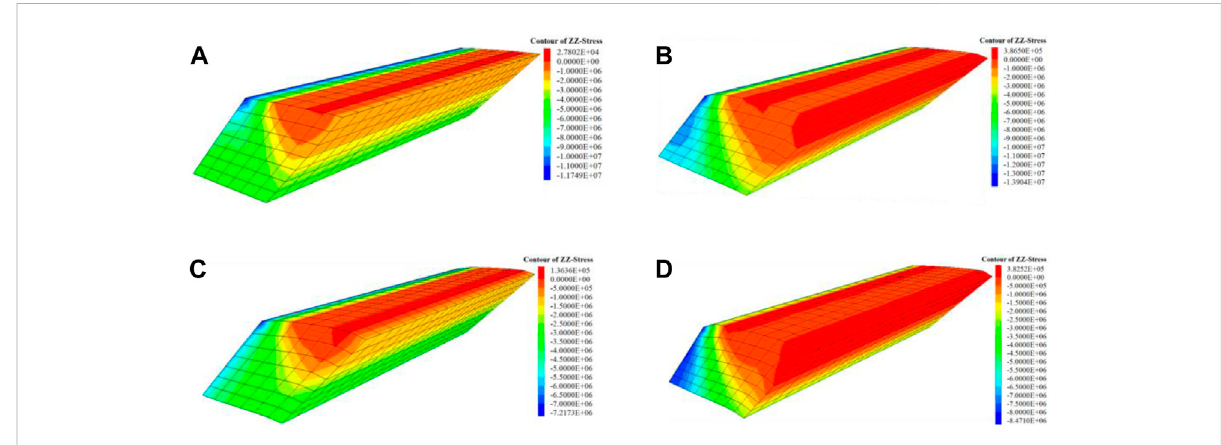
FIGURE 9 +575level 45#,43#coalseamstressdistributioncharacteristics. (A) Nowaterinjectionin45#coal. (B) Nowater injectionin43#coal. (C) Water injection in 45#coal. (D) Water injection in